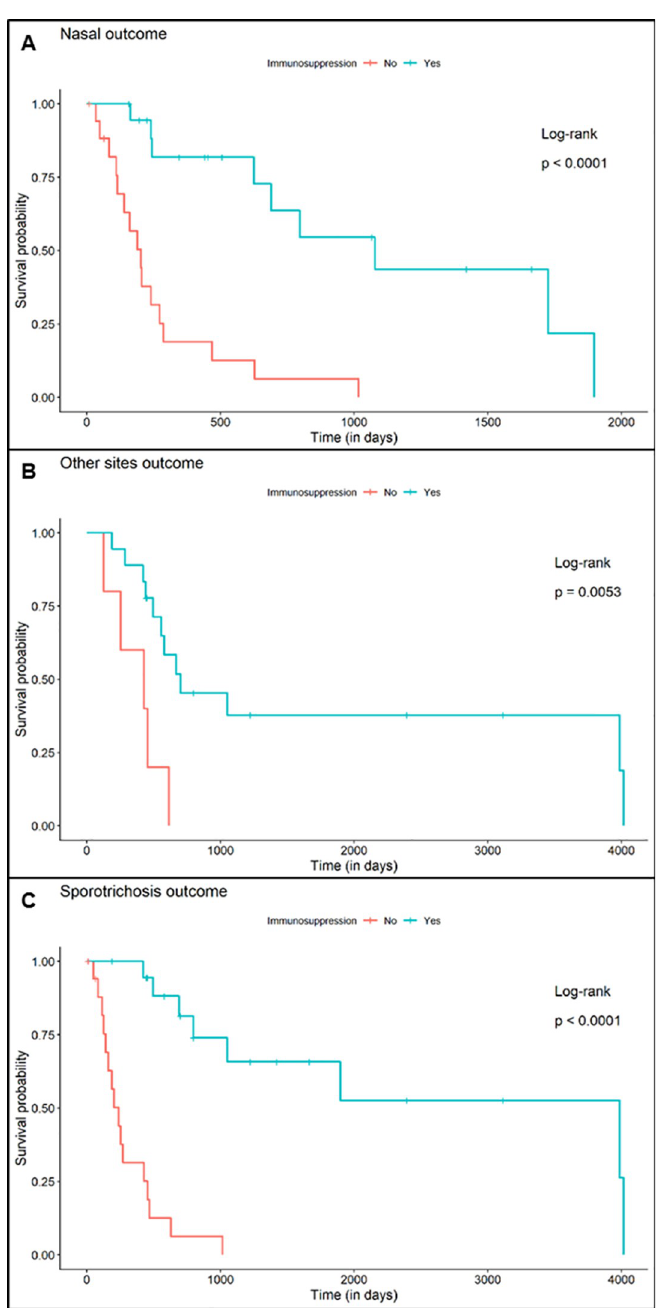
Fig 5. Comparative analysis of cure (Kaplan-Meier survival curves) in patients with and without immunosuppression. (A) Patients with sporotrichosis lesions in the nasal mucosa (Nasal outcome). (B) Patients with sporotrichosis lesions in other sites outcome, and in the general context (Sporotrichosis outcome). infection of people living with them [16]. The possibility of transmission of S . brasiliensis through the sneezes of cats with sporotrichosis was verified in a recent study [3]. The most diagnosed clinical presentations of sporotrichosis worldwide are lymphocuta- neous and fixed cutaneous [6], both localized forms of the disease. Disseminated and